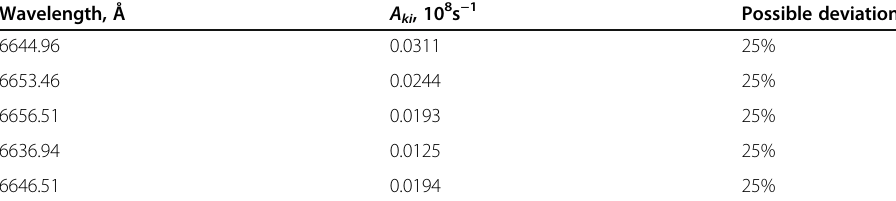
Table 5 Transition probabilities related to atomic lines within 663 – 665 nm Wavelength,